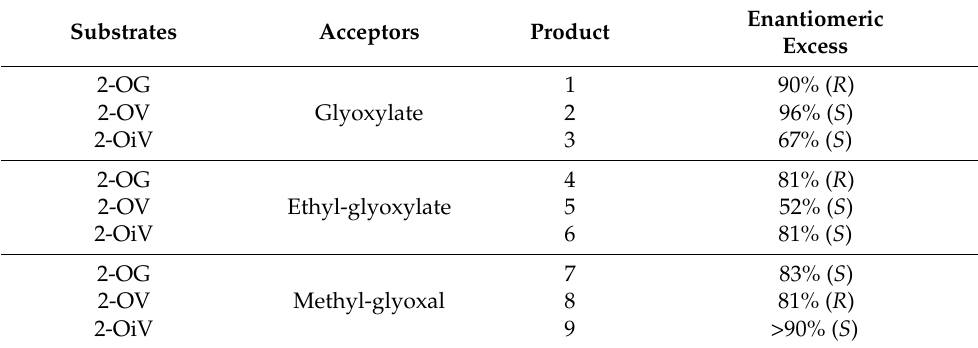
Table 2. Acetoin-like products formed by E. coli E1o (yield for all products was determined by 1 H NMR with no starting material detected) [97]. Substrates Acceptors Product